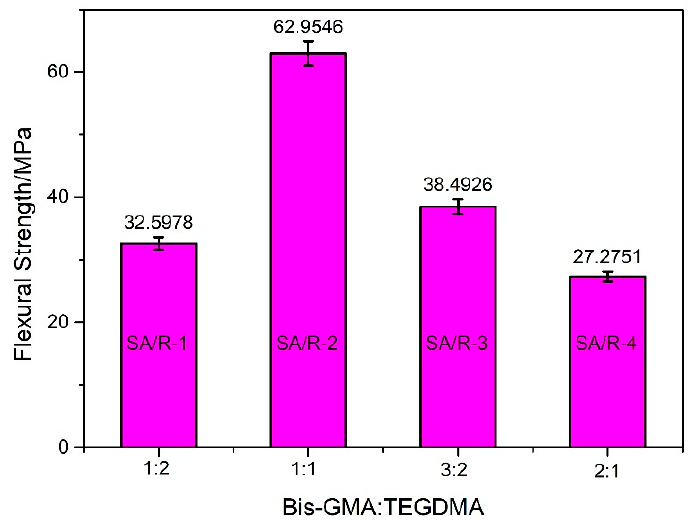
Figure 6. The flexural strength of blank samples, without silica aerogel, with different Bis-GMA: